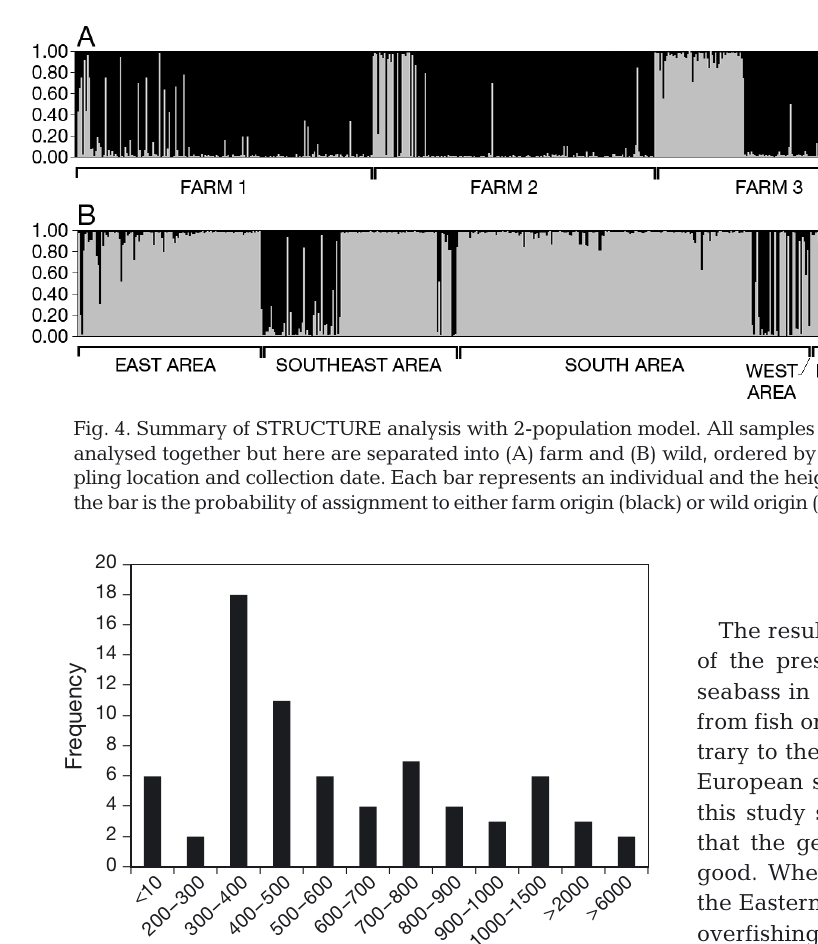
(Fig. 6a,b). Of the 4 haplogroups detected, farmed fish were restricted to only 2 groups, with almost 95% displaying the same group (haplogroup 1), whereas wild fish showed all 4 groups and up to 30% of indi- viduals had polymorphisms at one or more loci. An